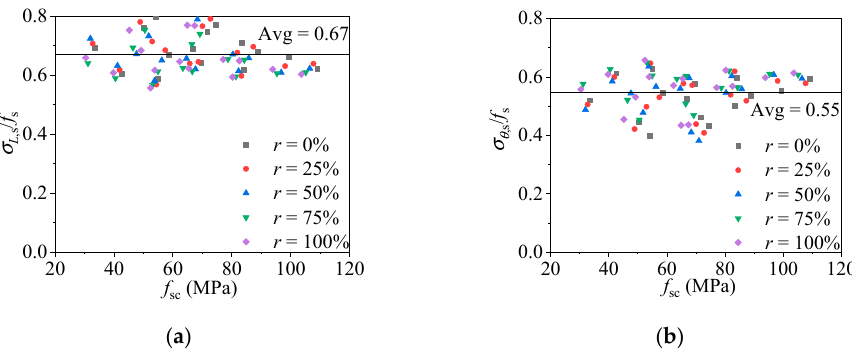
Figure 12. Axial compressive stress and transverse stress of RACFST stub column: ( a ) average ratio of axial compressive stress to the yield stress of the steel tube; ( b ) average ratio of tensile transverse stress to the yield stress of the steel tube.